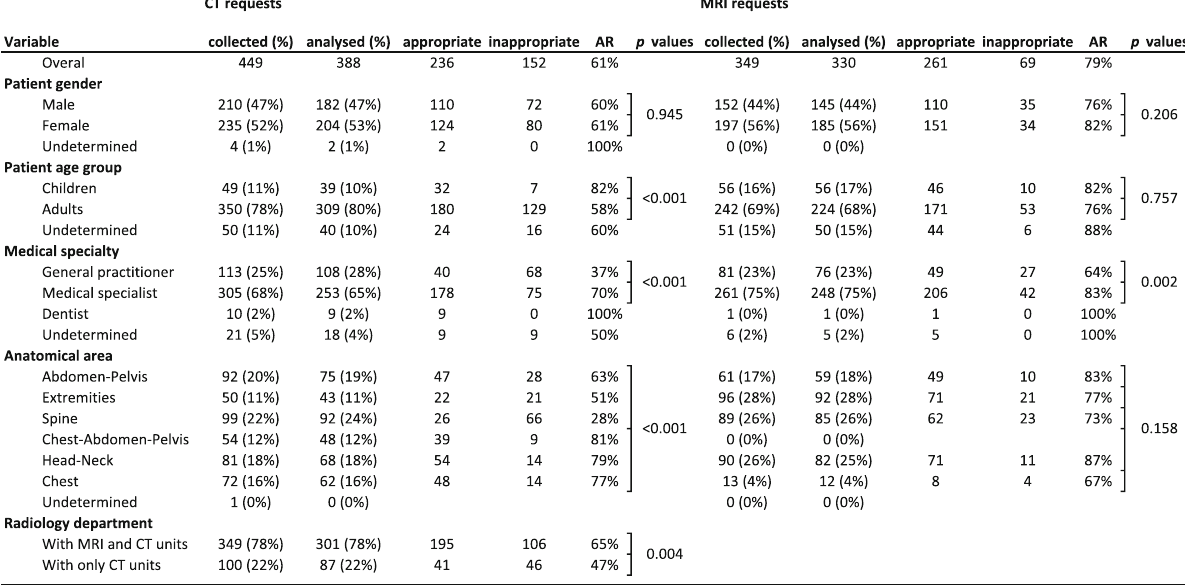
Table 1 Number and proportion of requests collected in the radiology departments, number and proportion of analysed requests, number of appropriate and inappropriate requests and appropriateness rates (AR) for CT and MRI requests according to patient gender, patient age group, medical speciality of referrer, anatomical area and radiology department depending on the presence of MRI units. Statistical significance if p value <